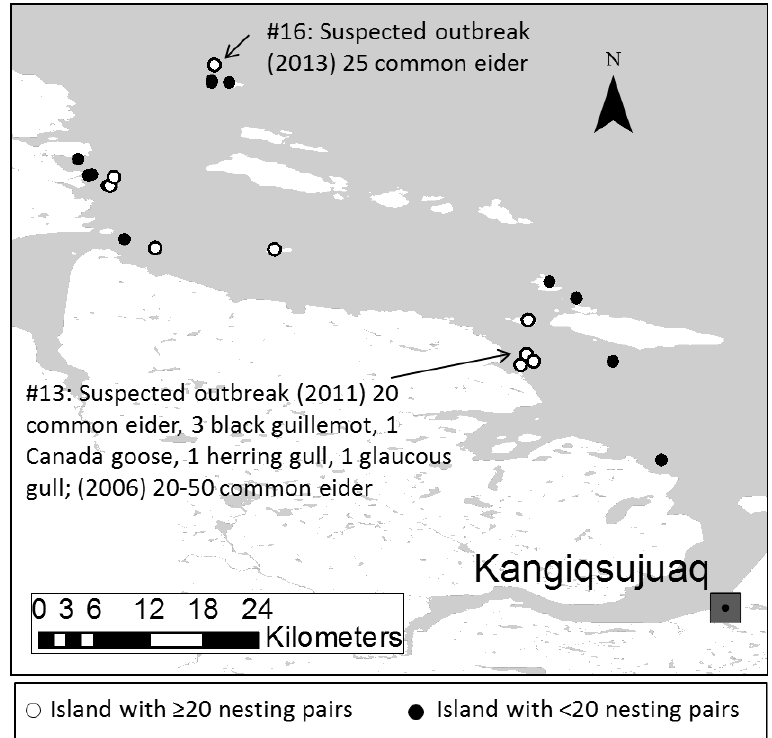
Figure A1.5. Survey zone 5: King George Sound, Central Ungava Peninsula